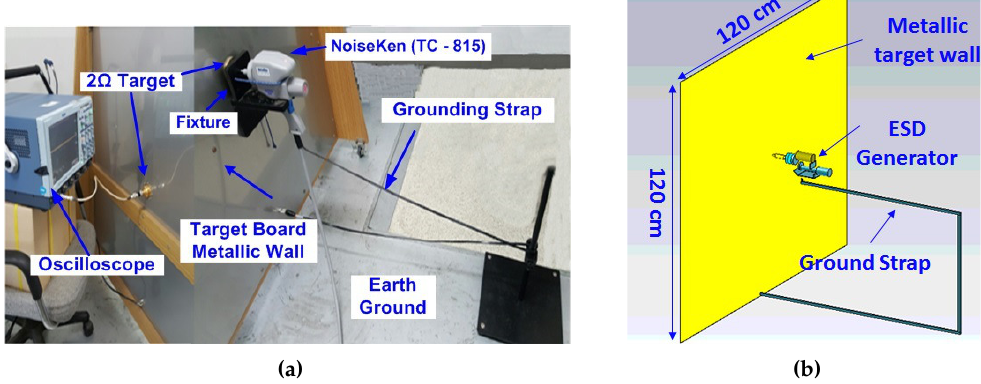
Figure 2. Reference ESD current waveform calibration setup: ( a ) IEC standard waveform measurement calibration setup; and ( b ) 3D model of calibration setup with developed Noiseken TC-815 ESD gun model in CST microwave studio (MWS).